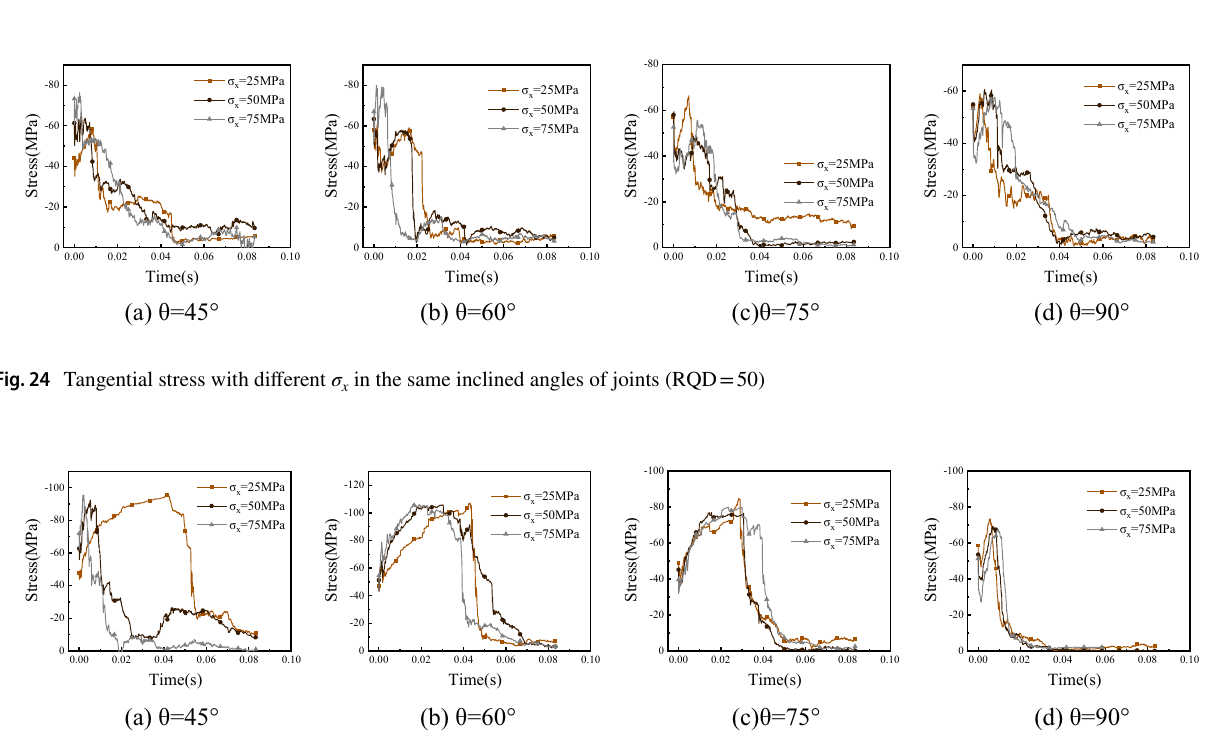
x = σ y = 70 MPa and RQD = 70)